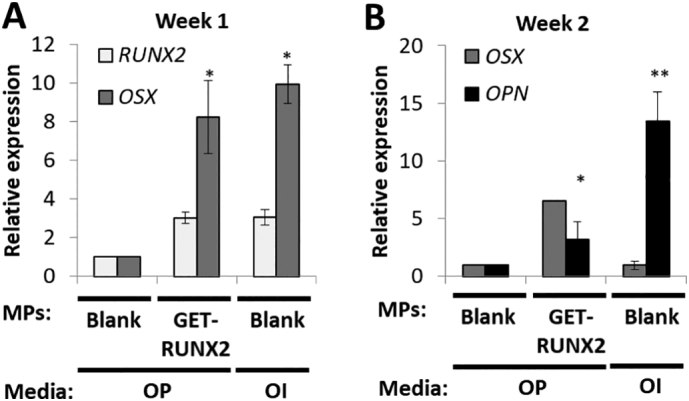
hMSC osteogenic gene expression analysis on PLGA/PEG scaffolds. Blank MPs represents cell-seeded scaffold containing blank MPs, cultured in osteo-permissive (OP) media. RUNX2-loaded MPs represents cellseeded scaffolds containing P21-RUNX2-8R loaded MPs, cultured in osteopermissive (OP) media. OI represents cell-seeded scaffolds containing blank MPs, cultured in osteo-inductive (OI) media. RNA was extracted from hMSCs at week 1 (A) and week 2 (B) and gene expression analysis using Q-RTPCR was performed. The results were plotted based on expression fold change to noninduced hMSCs on blank scaffold using the ΔΔCT method. Data is presented as mean ± SE. * p.